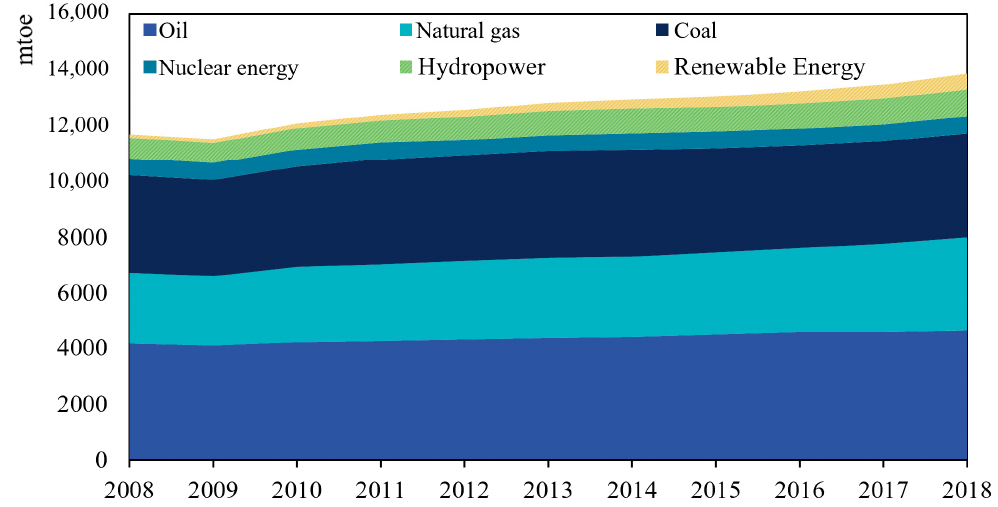
Figure 1. Global energy consumption and composition.